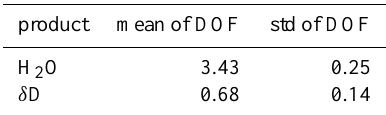
Table 2. Assumed spectroscopic parameter uncertainty for H 2 O and HDO.